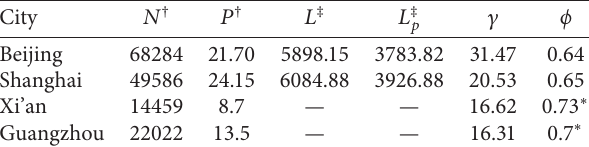
Table 1: Traditional indicators for measuring taxi